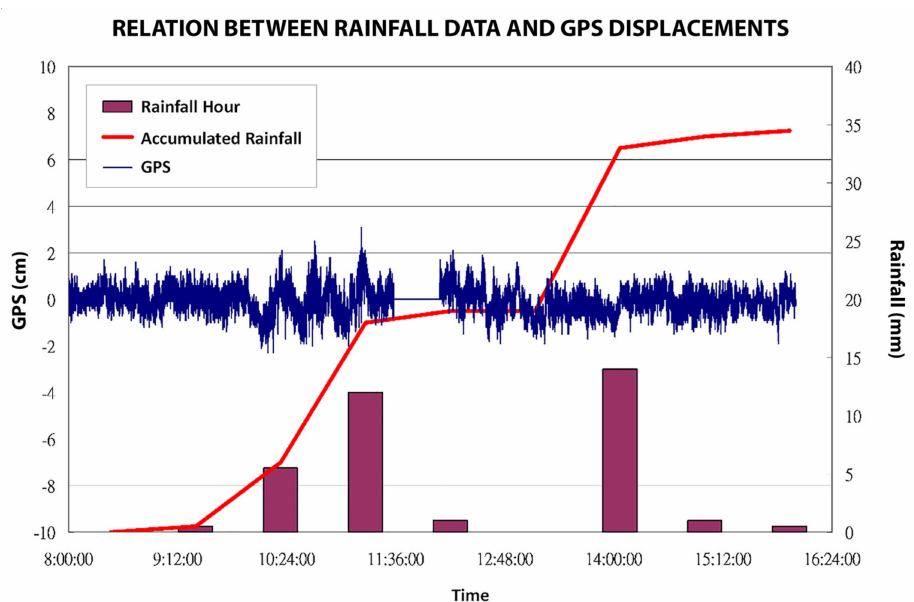
Figure 13. Relationship between Hourly Rainfall and GPS